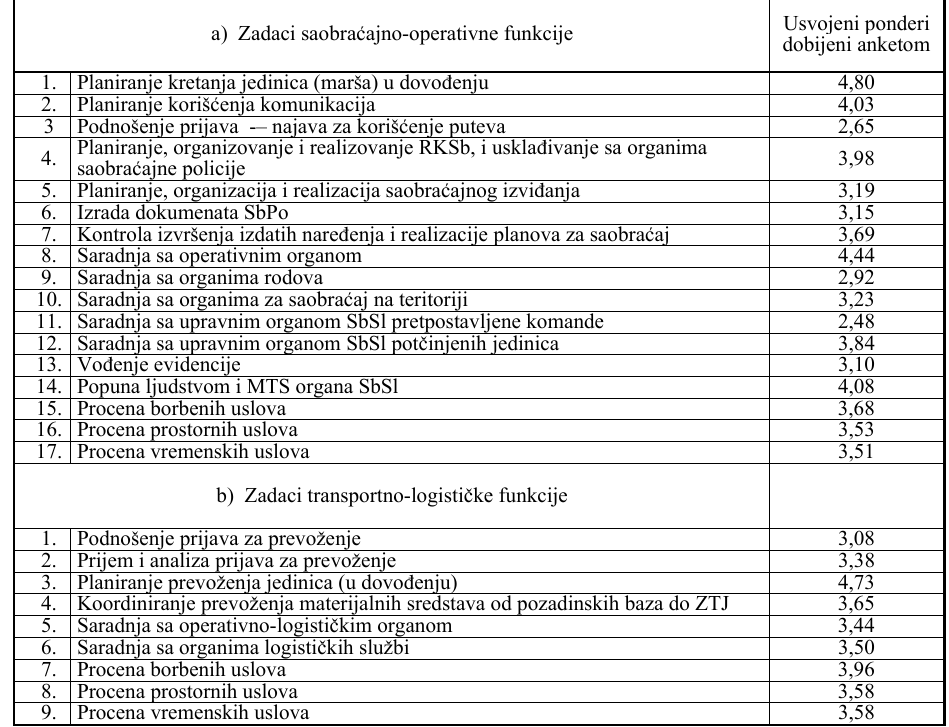
Ponderi zadataka funkcija SbPo u pripremi